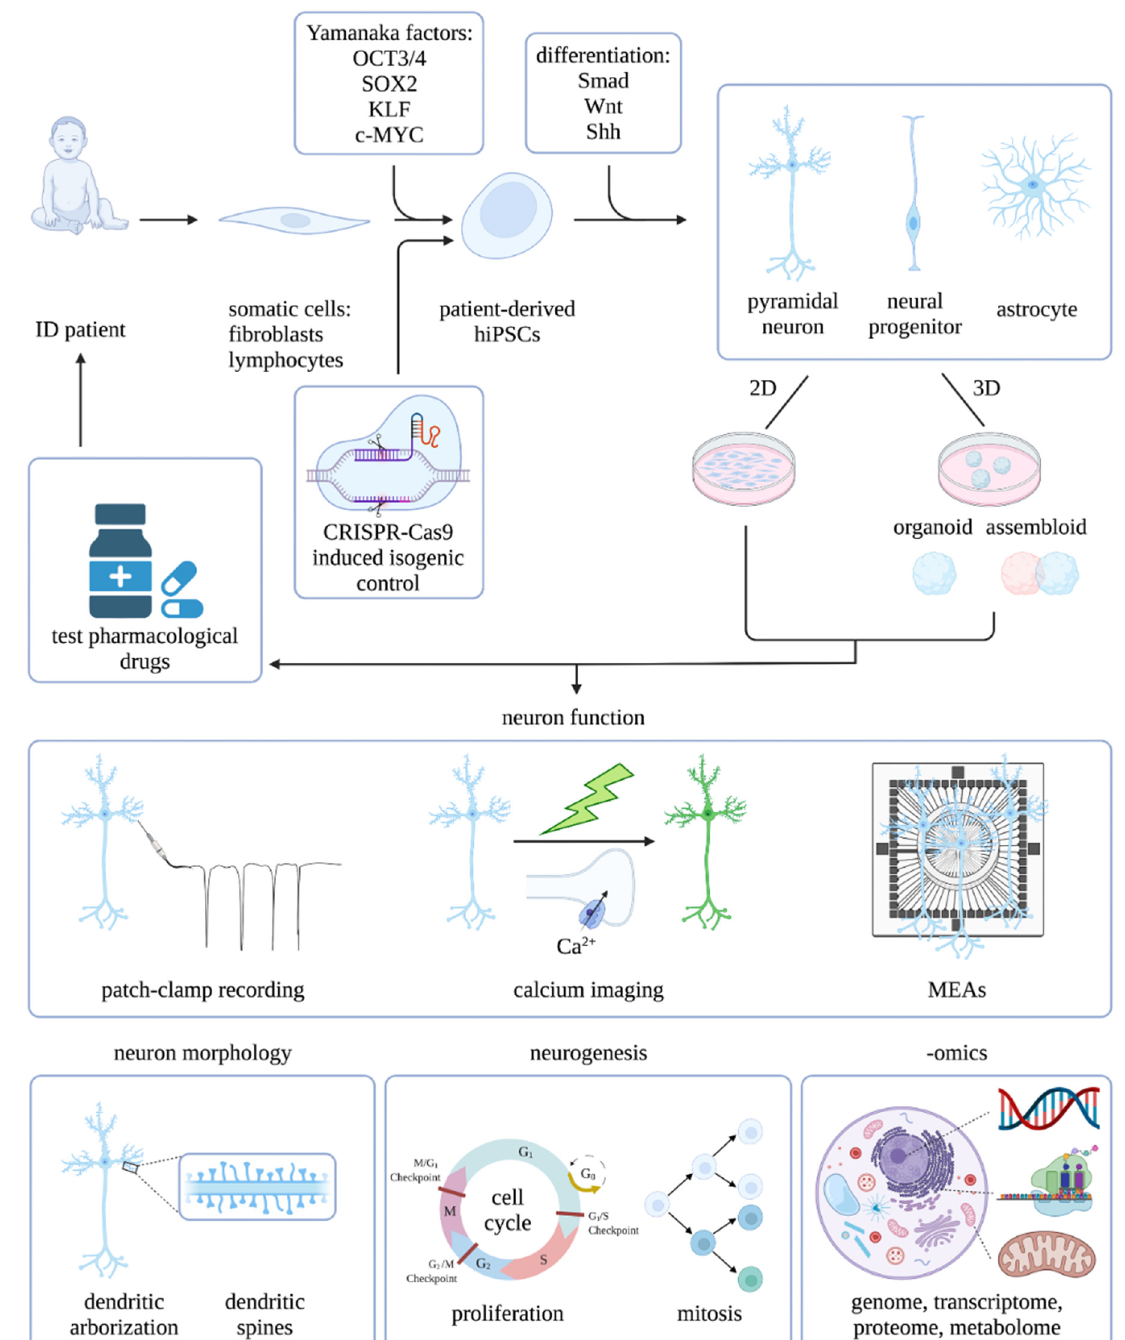
Figure 1. In vitro human brain models of ID. Patient-derived somatic cells are reprogrammed into iPSCs using Yamanaka factors (OCT34, SOX2, KLF, c-MYC). CRISPR-Cas9-induced